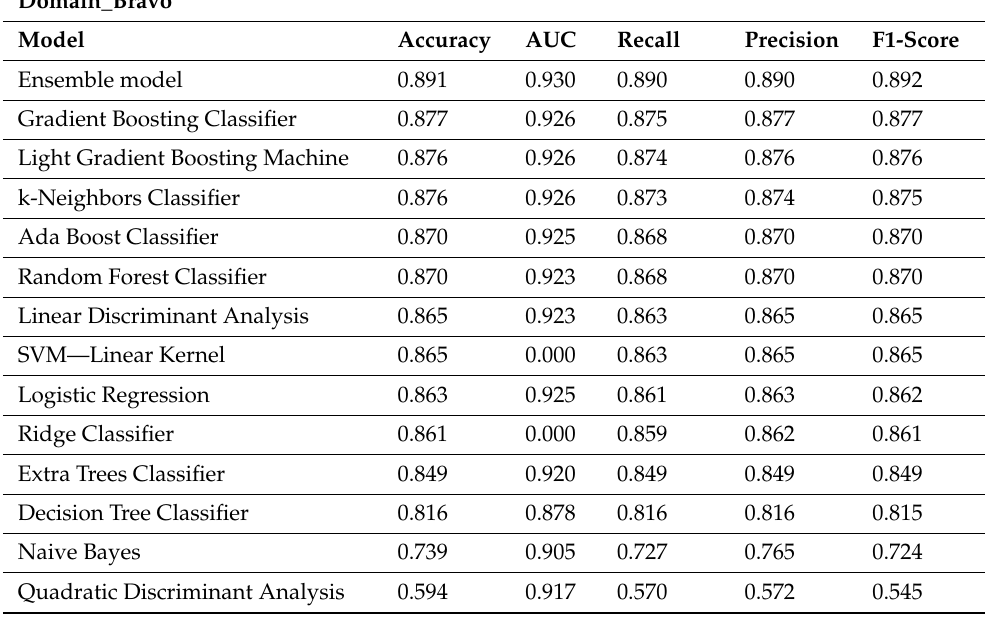
Table 8. Ensemble model for the Domain Bravo.